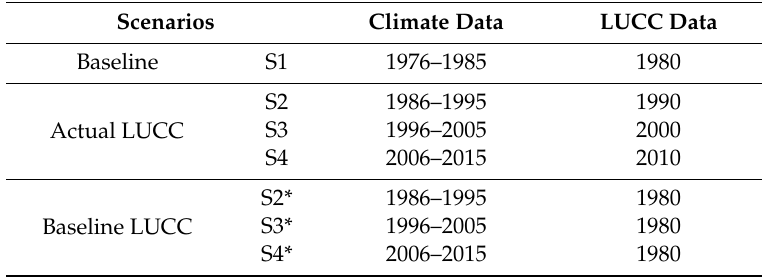
Table 2. Scenario setting based on climate and land use and land cover change